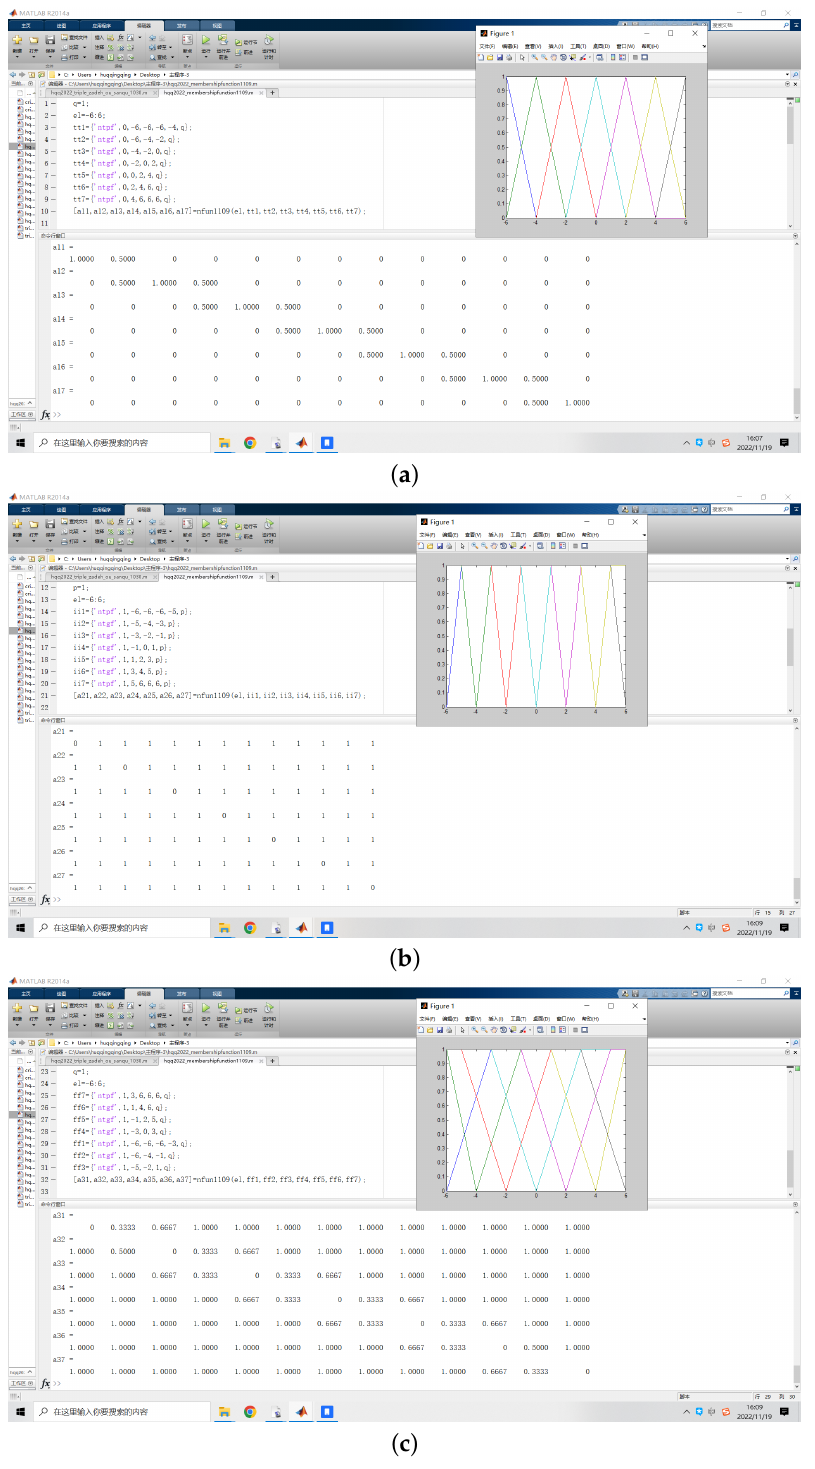
Figure 1. The truth-membership functions ( a ), indeterminacy-membership functions ( b ) and falsity- membership functions ( c ) of three-way fuzzy subsets of e , ec and u